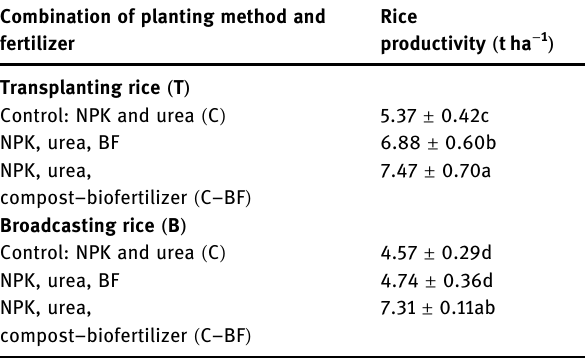
Table 5: Rice yield grown under transplanting and broadcasting methods in di ff erent fertilizer compositions Combination of planting method and